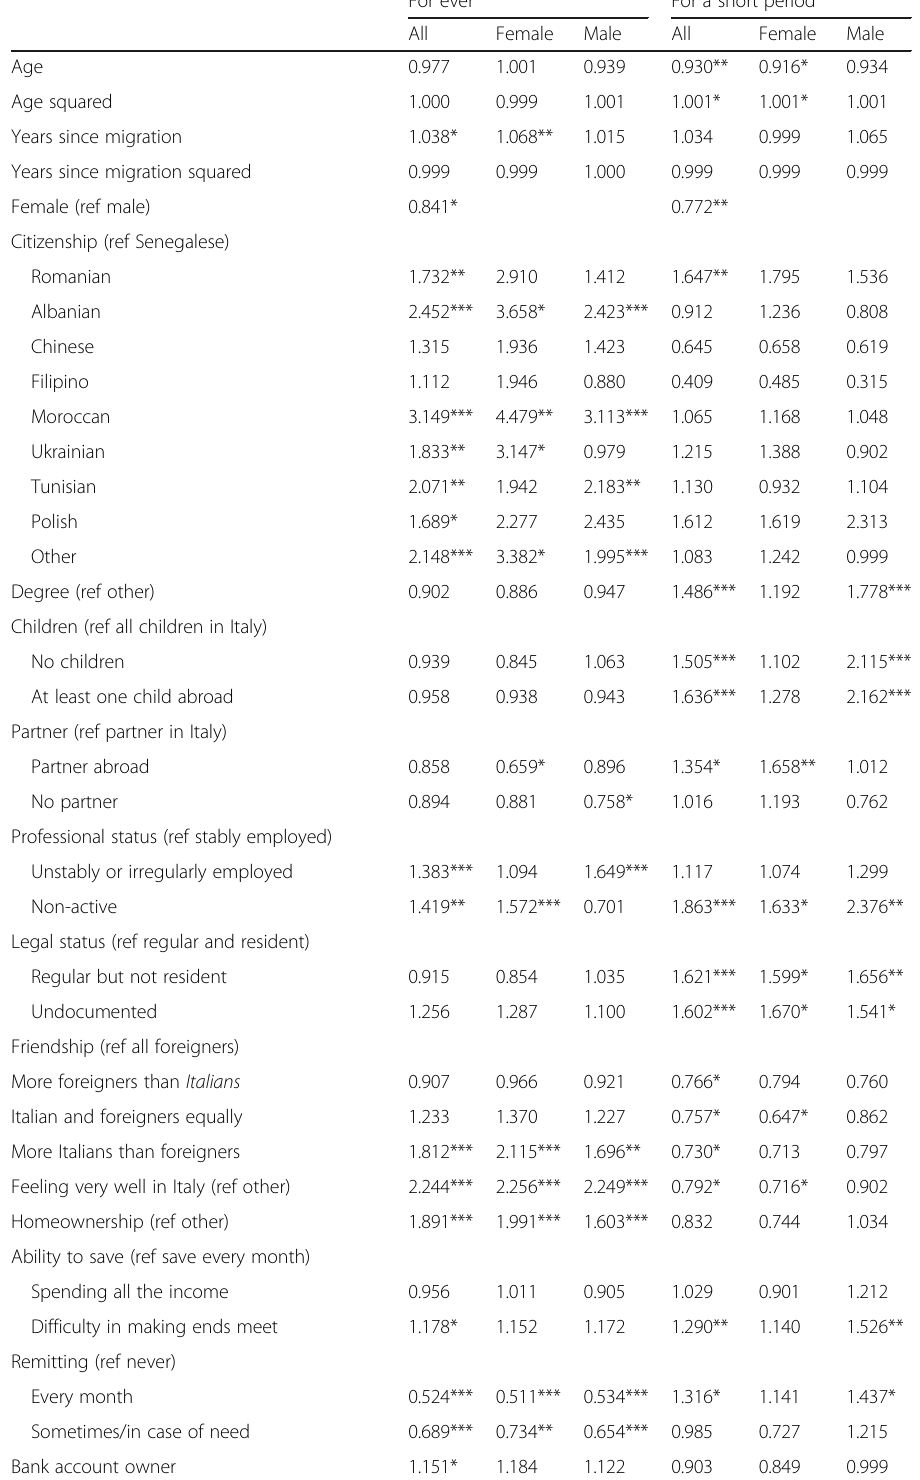
Table 3 Odds ratios and significance from the multinomial logistic regression models dependent variable length of stay (baseline ‘ for a long time ’ ) For